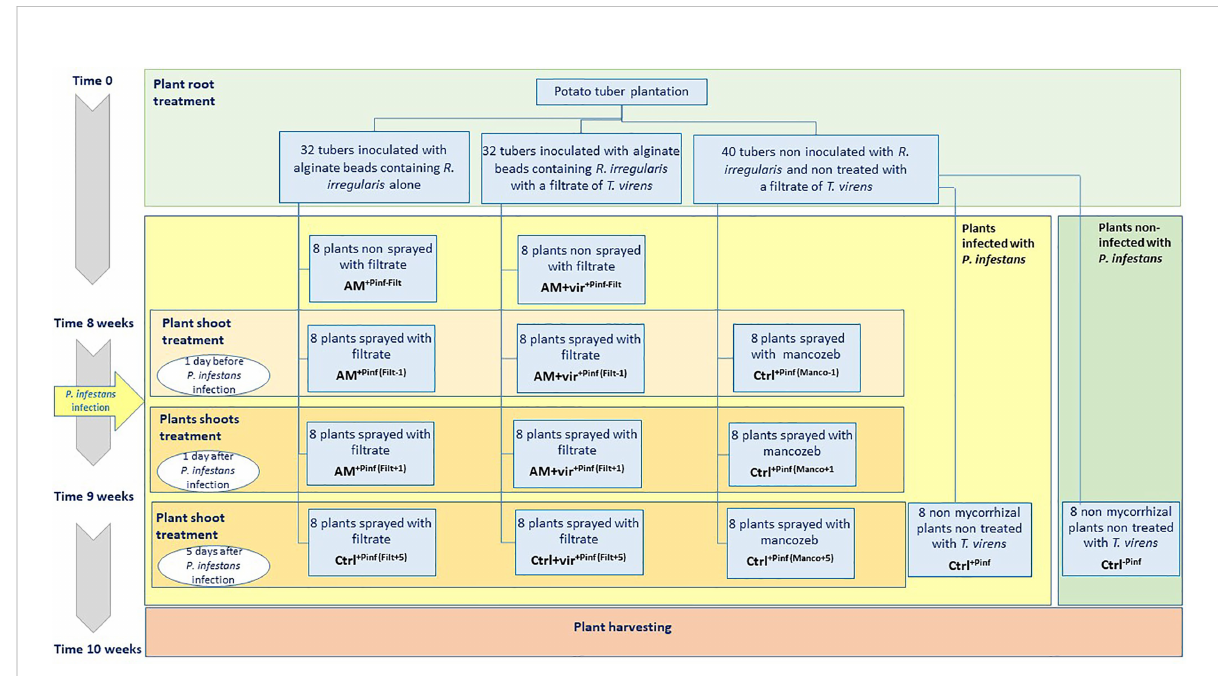
FIGURE 1 Schematic representation of the experimental design of experiment 3. Evaluation of the combined effects of a culture fi ltrate of T. virens MUCL 18139 and R. irregularis MUCL 41833 on the disease severity caused by P. infestans MUCL 54981 on potato var. Annabelle under controlled greenhouse